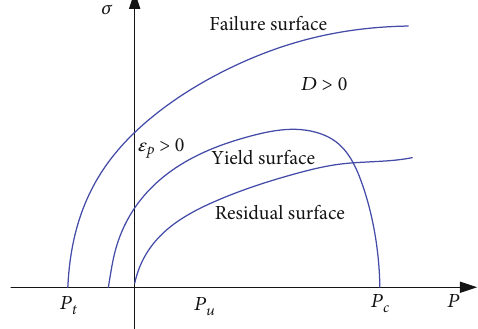
Figure 2: Stress limit surfaces and loading path